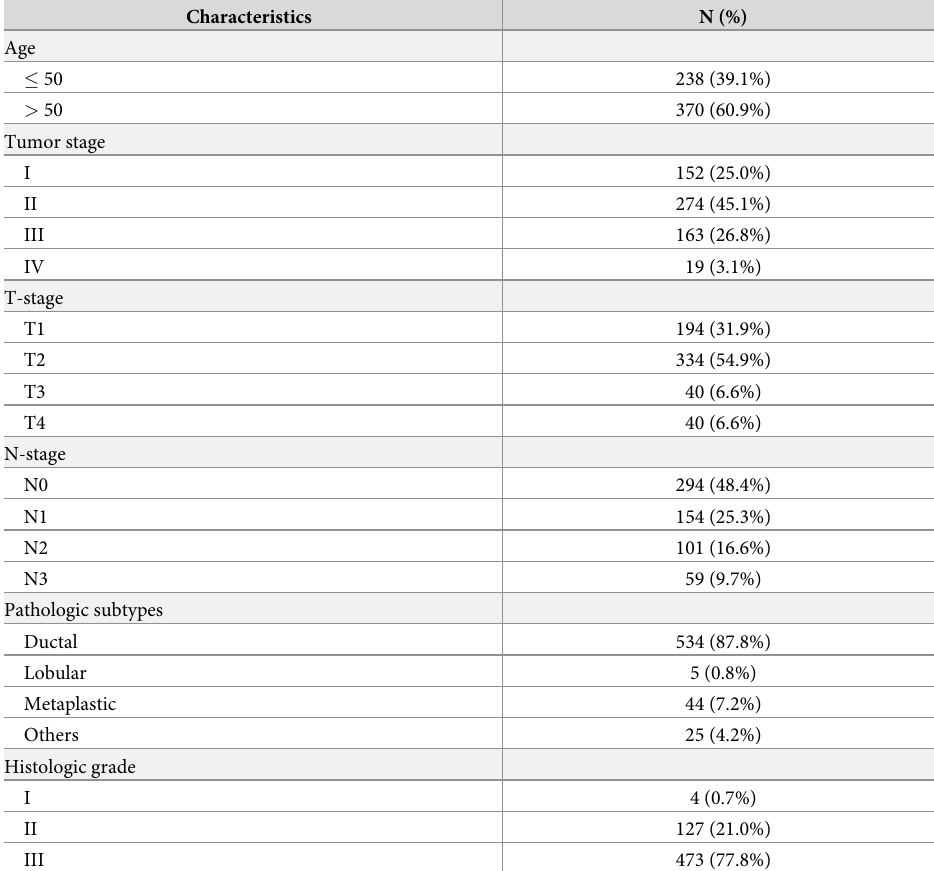
Table 1. Patient